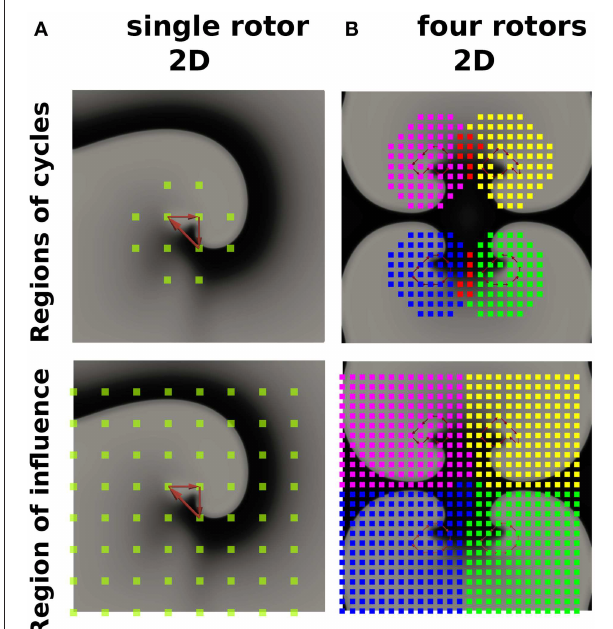
FIGURE 8 | The regions of cycles and the regions of influences for model (A) (single rotor) and model (B) (four rotors). Models (A,B) were simulated with 64 resp. 625 electrodes. The smallest cycles are depicted in red. Different regions of cycles were depicted in different colors, while the overlap is shown in red. Similarly, different regions of influence are shown in different colors, dividing model B into four different